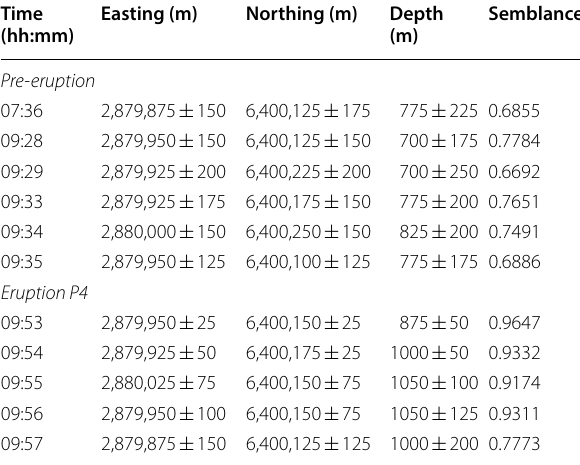
Table 2 Summary of semblance locations for pre- and syn- eruption VLP activity filtered from 0.03 to 0.1 Hz